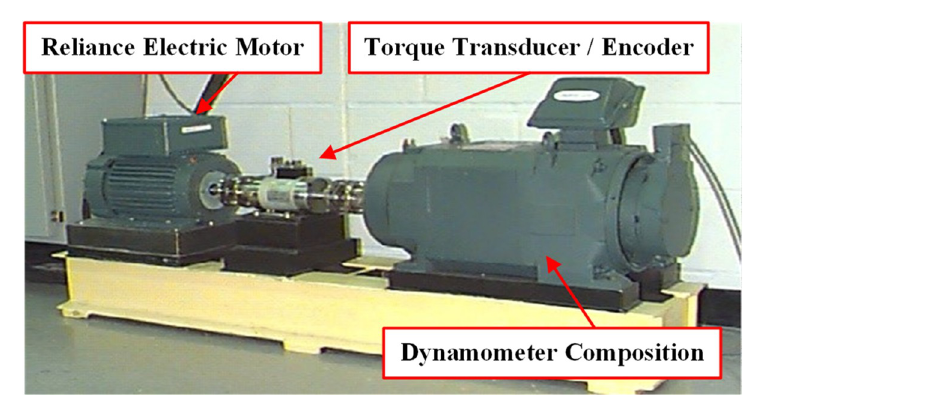
Fig 8. Experiment